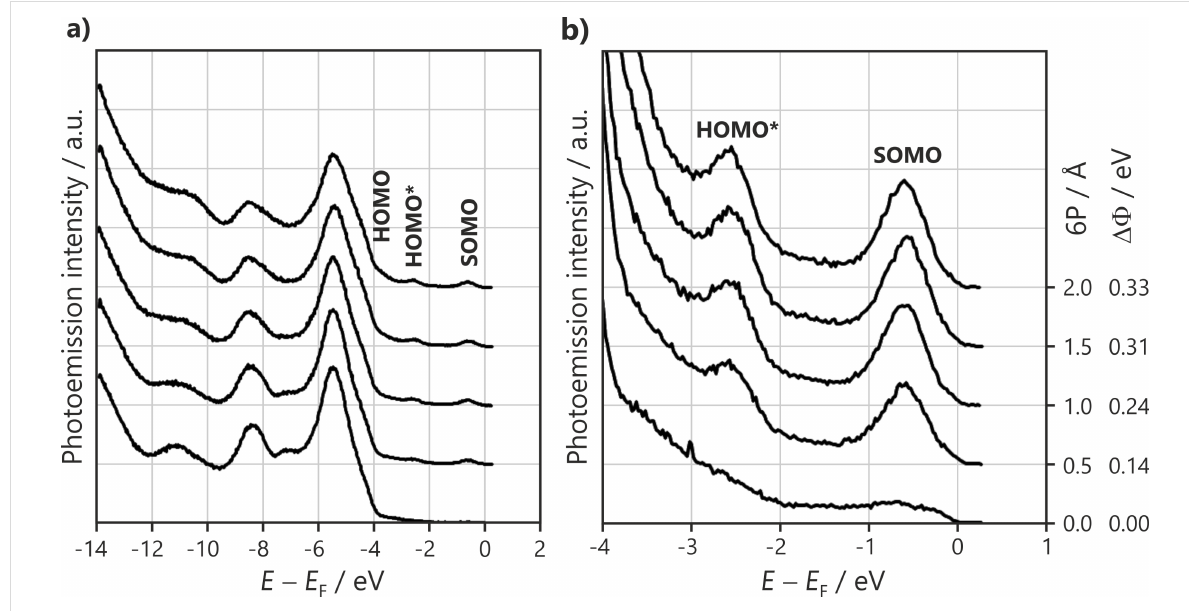
Figure 5: He I ARUPS spectra for a 6P dosing series on 2 ML MgO(100)/Ag(100) ( Φ MgO = 2.58 eV) recorded at a takeoff angle of 50° in the [001] azimuth. (a) Full scan and (b) magnification of the molecular emissions in the MgO bandgap. 6P exposure and change in the work function upon deposition are indicated on the